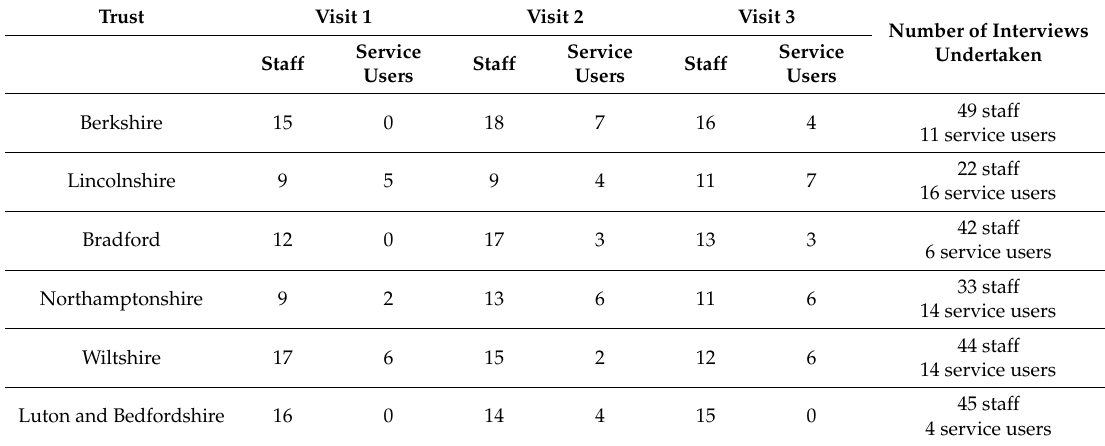
Table 2. Interviews undertaken across the sites.